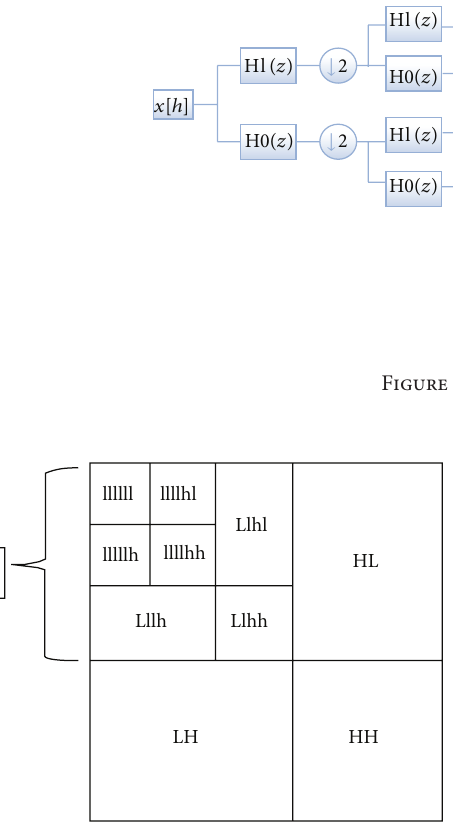
Figure 3: Standard 2D DWT decomposition.